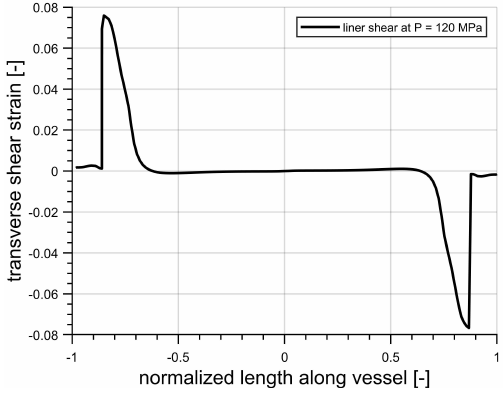
Figure 13. Shear strain in the